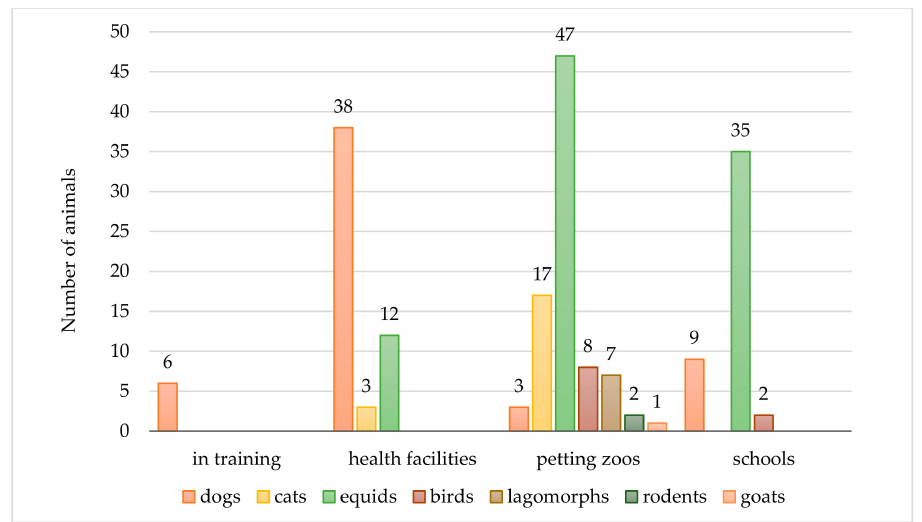
Figure 1. Number of study animals and their distribution in the main settings of animal-assisted interventions (AAIs).